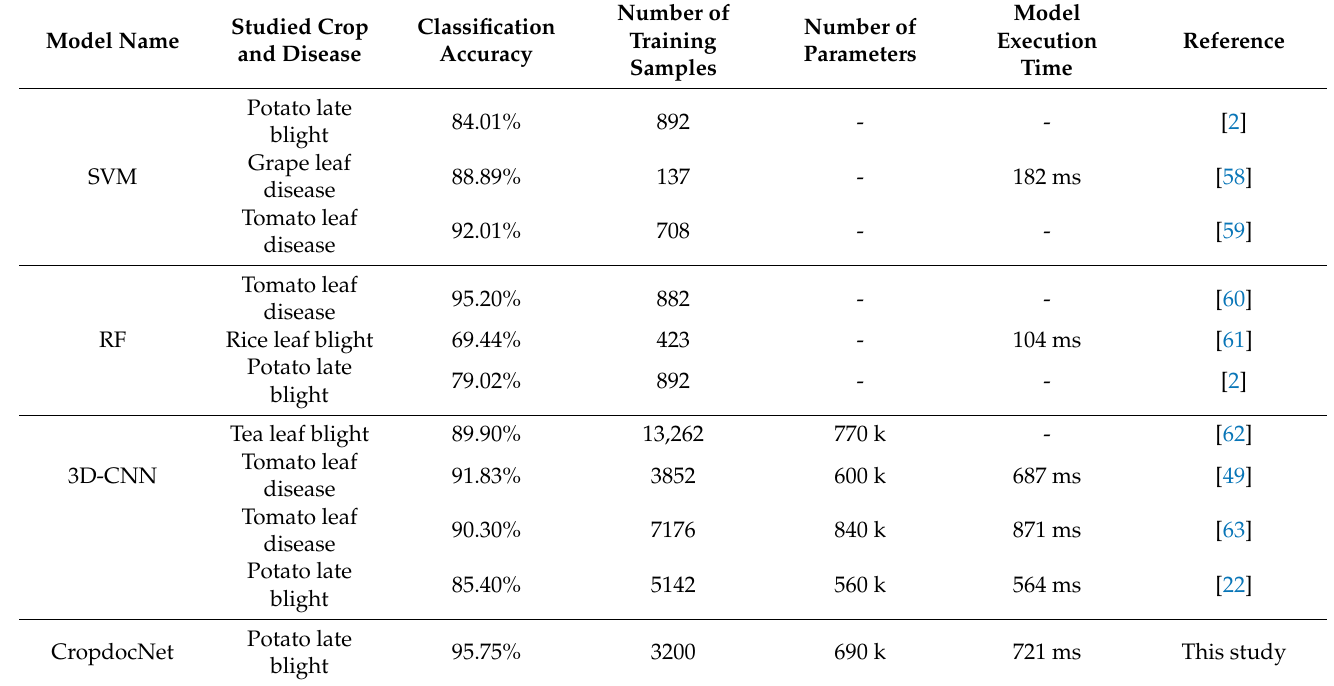
Table 6. The performance comparison of the proposed CropdocNet model with the existing study cases. Note: “-” means no record found in the relevant